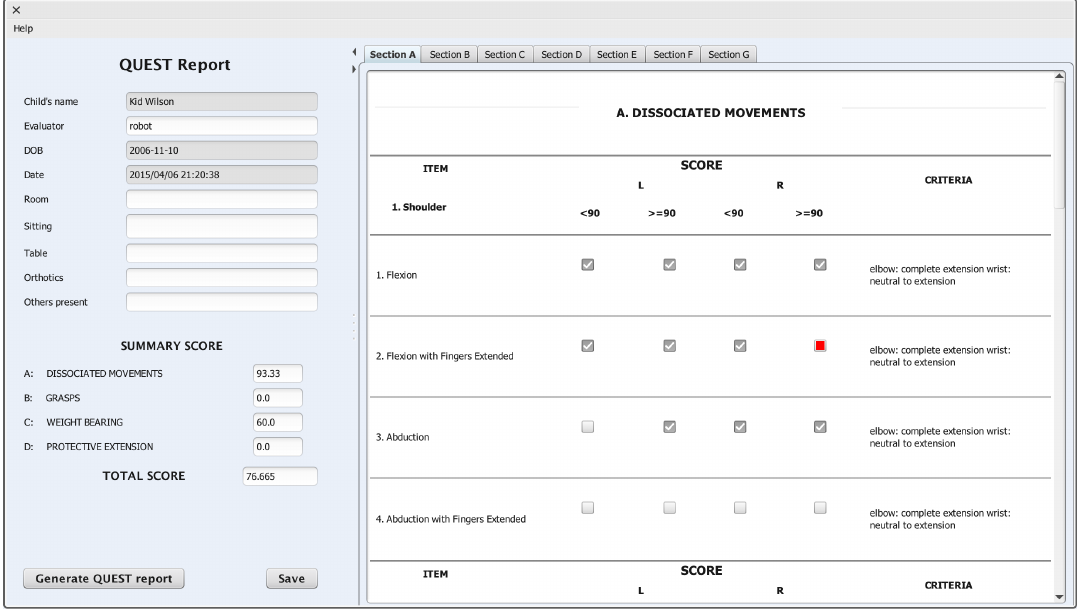
Figure 11. NAOTherapist sessions and